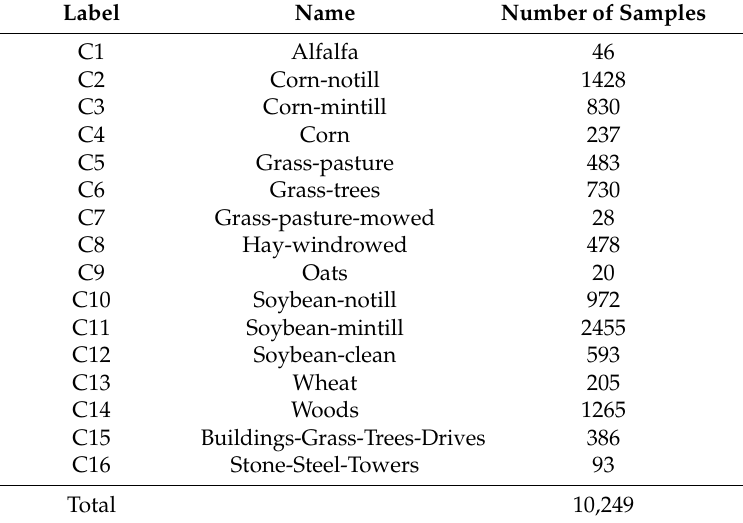
Table 1. Indian Pines dataset ground object type